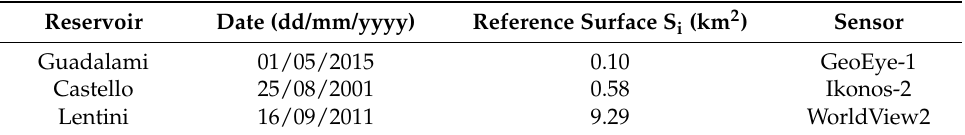
Table 1. Reference surface of selected reservoirs.